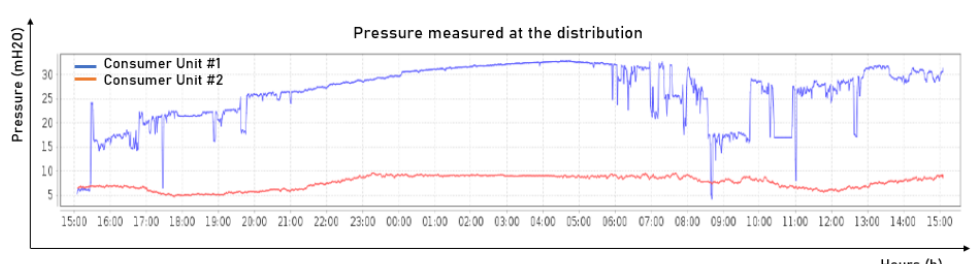
Figure 17. Distribution pressure comparison. Source: Cagepa,